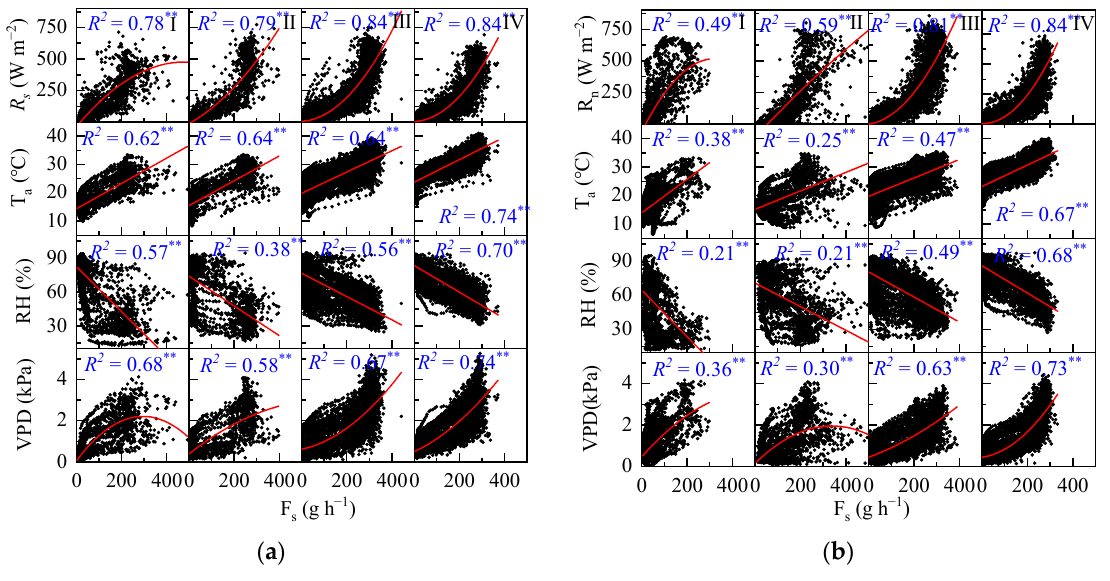
Figure 3. Correlation analysis between instantaneous transpiration (F s ) and environmental factors. ( a ) 2020; ( b ) 2021. * Indicates significant correlation between independent variable and dependent variable ( p < 0.05); ** Indicates highly significant correlation between independent variables and dependent variables ( p < 0.01). I, II, III, and IV respectively represent the new growth period, flowering and fruit setting period, fruit expansion period, and fruit maturation period.